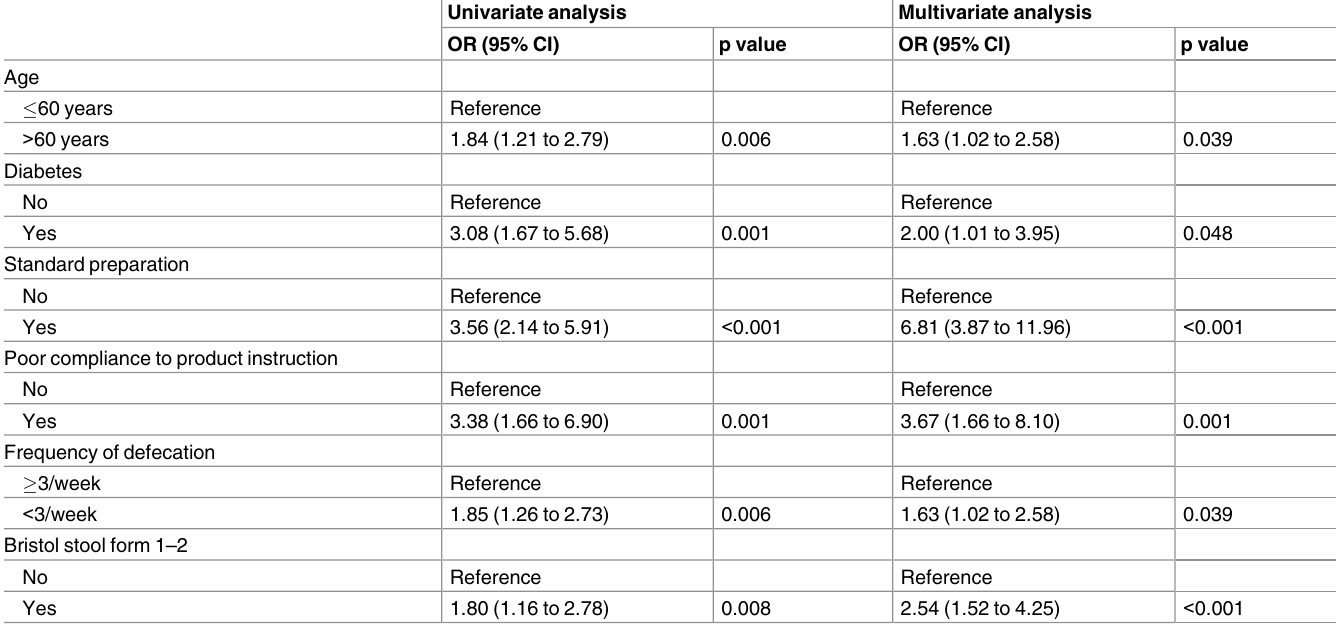
Table 5. Univariate and multivariate analysis of factors associated with inadequate bowel